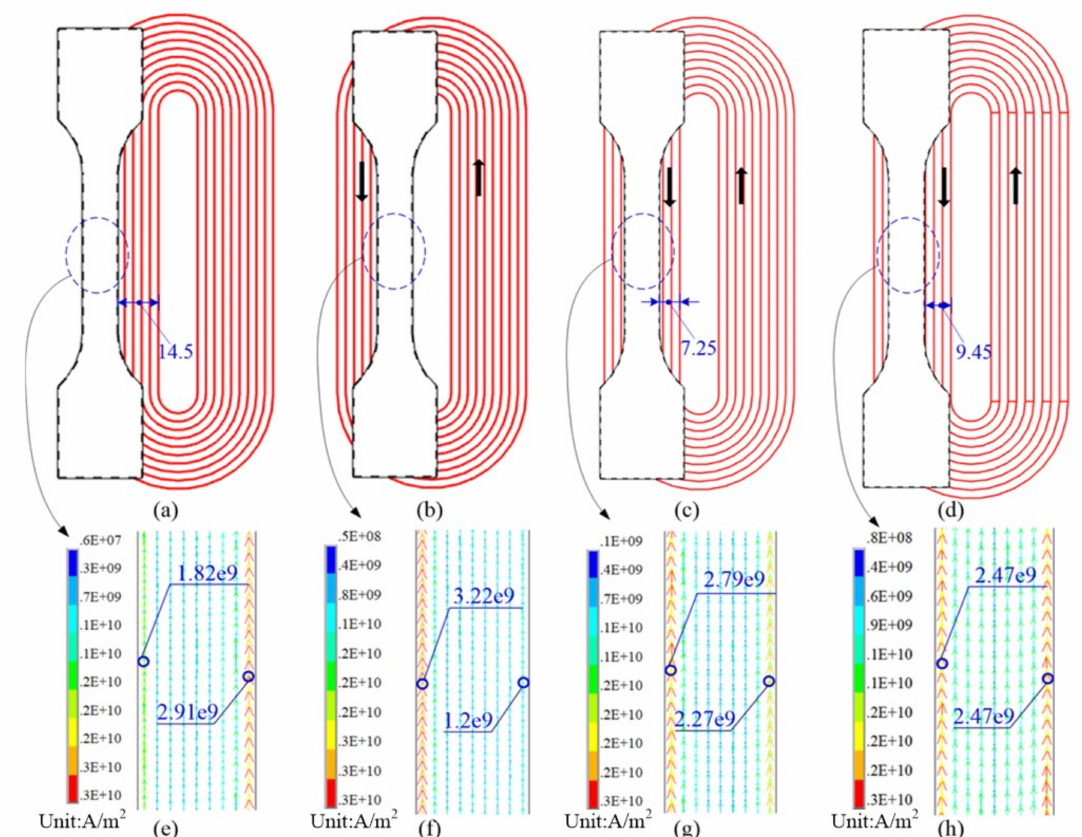
Figure 7. Effect of the relative position of the coil and sample on the current density with ( a ) h = 14.5 mm, ( b ) h = 0 mm, ( c ) h = 7.25 mm, and ( d ) h = 9.45 mm ( e ) current value with h = 14.5 mm ( f ) current value with h = 0 mm, ( g ) current value with h = 7.25 mm, ( h ) current value with h = 9.45 mm.